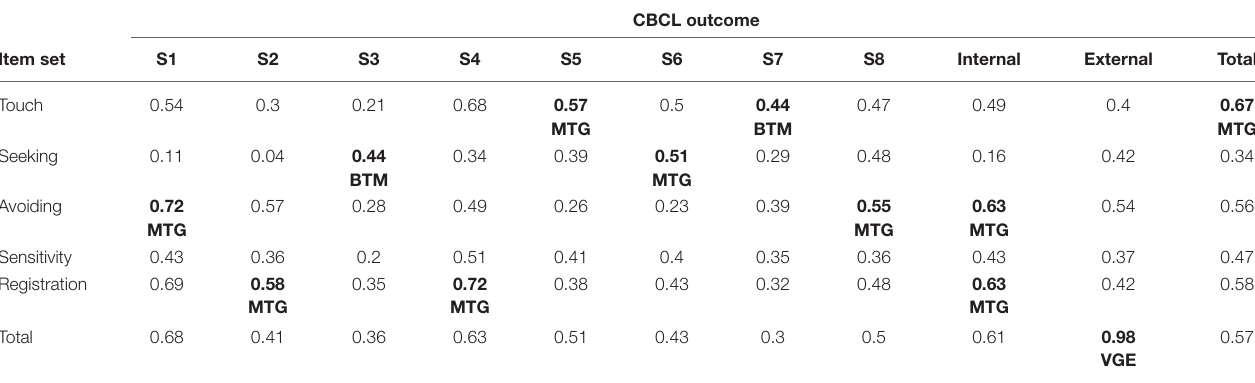
TABLE 2 | The best R for each outcome over the scales is in bold, labeled by performance levels as: BTM (bad to moderate), MTG (moderate to good), and VGE (very good to excellent).